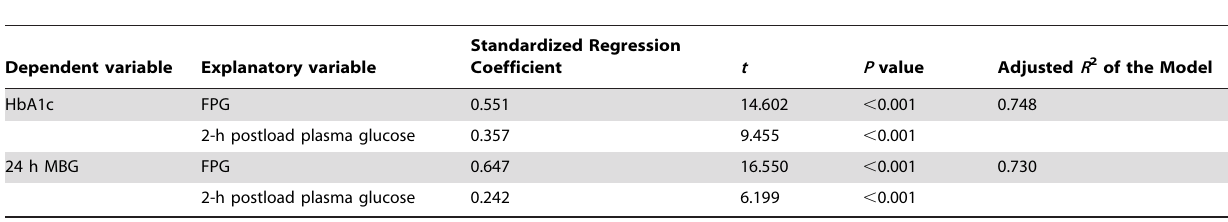
Table 3. Multiple stepwise regression analysis with HbA1c or 24 h MBG as a dependent variable ( n